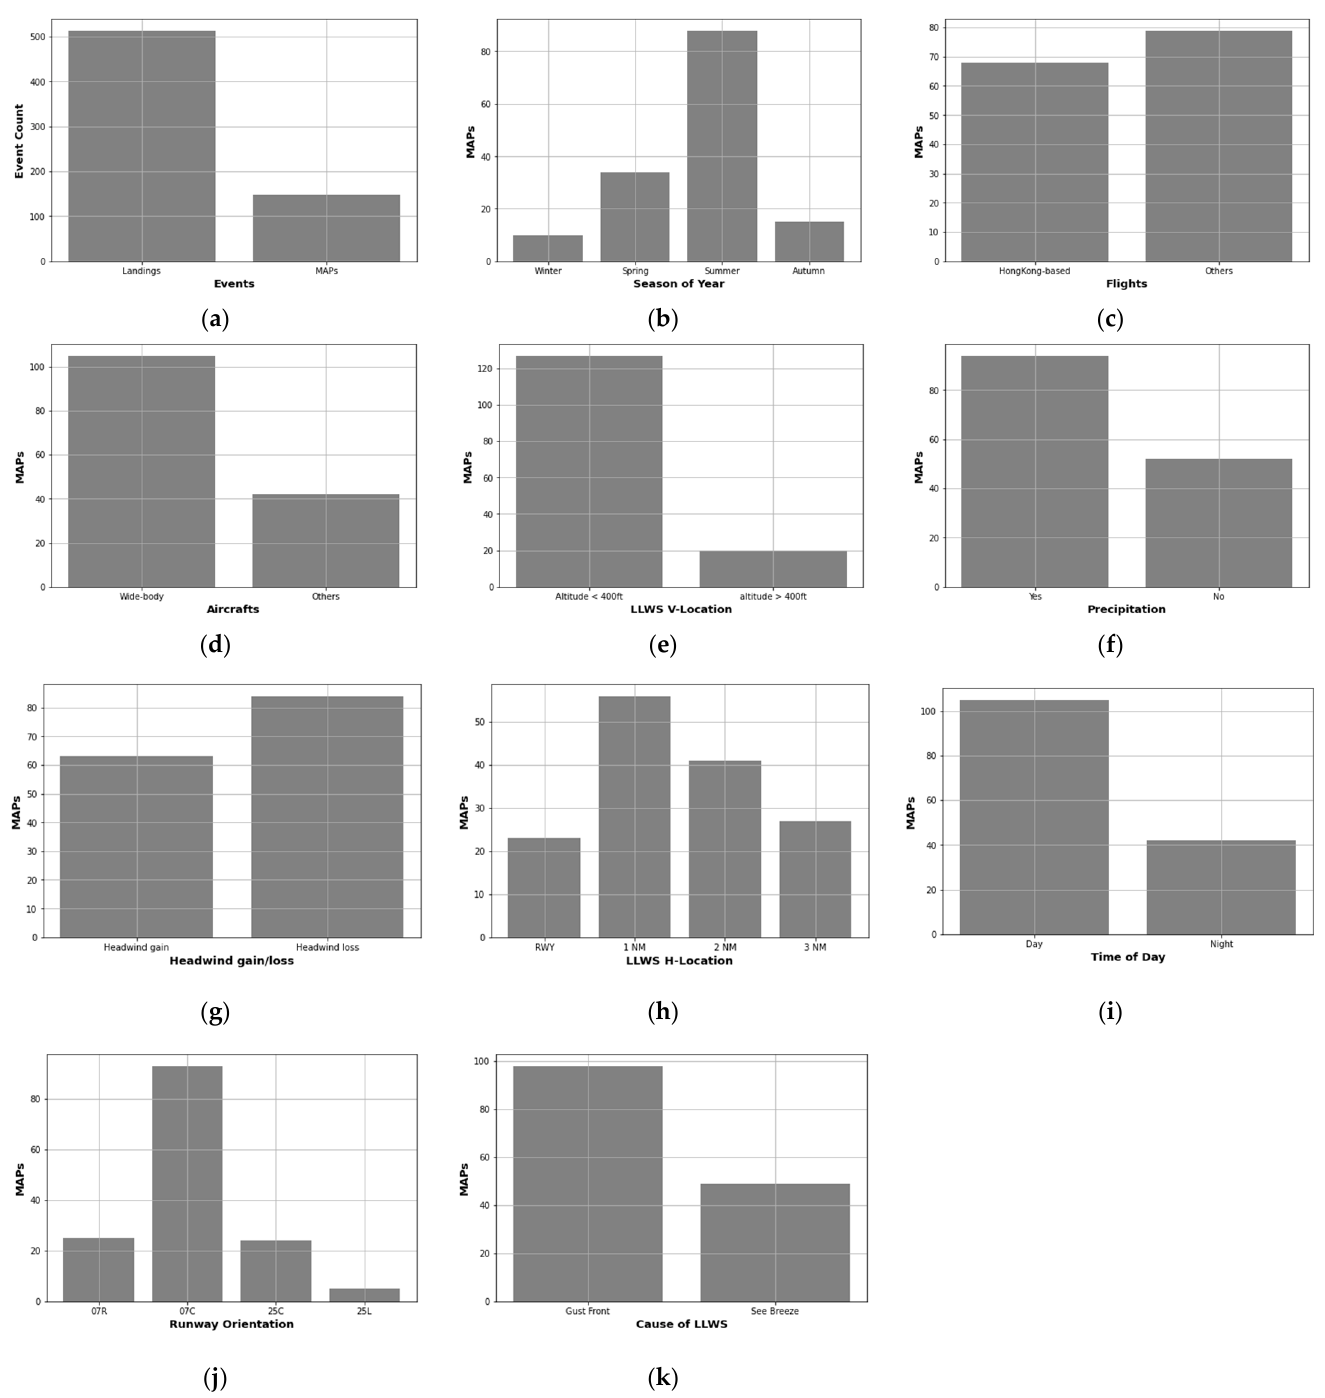
Figure 6. Distribution of go-around with respect to environmental and situational factors (a) Distribution of Landing (approaches) and MAPs (Go-around); (b) Distribution of Go-around in different season of years; (c) Distribution of Go-around with respect to type of flight; (d) Distribution of Go-around with respect to type of aircraft; (e) Distribution of Go-around with respect to altitude (V-Location) of the wind shear; (f) Distribution of Go-around with respect to precipitation (g) Distribution of Go-around with respect to wind shear magnitude; (h) Distribution of Go-around with respect to wind shear horizontal (H)-location; (i) Distribution of Go-around with respect to time of the day; (j) Distribution of Go-around with respect to corridor/ runway orientation; (k) Distribution of Go-around with respect to wind shear causes.